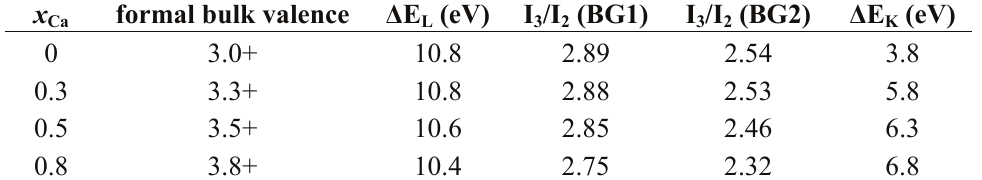
a systematic Mn valence increase between 3+ and 4+. Table 1. Mn valence indicators obtained from the Mn L- and O K-edge spectra of virgin samples under ultra-high vacuum (UHV) conditions. The energetic distance between the Mn L and L edges ( ∆ E ), their intensity ratio (I /I ) after subtraction of a constant L 3 2 L 3 2 background (BG1) or linear backgrounds for each edge (BG2, see Appendix) as well as the distance between the pre-edge feature and the first main resonance of the O K- edge (ΔE are